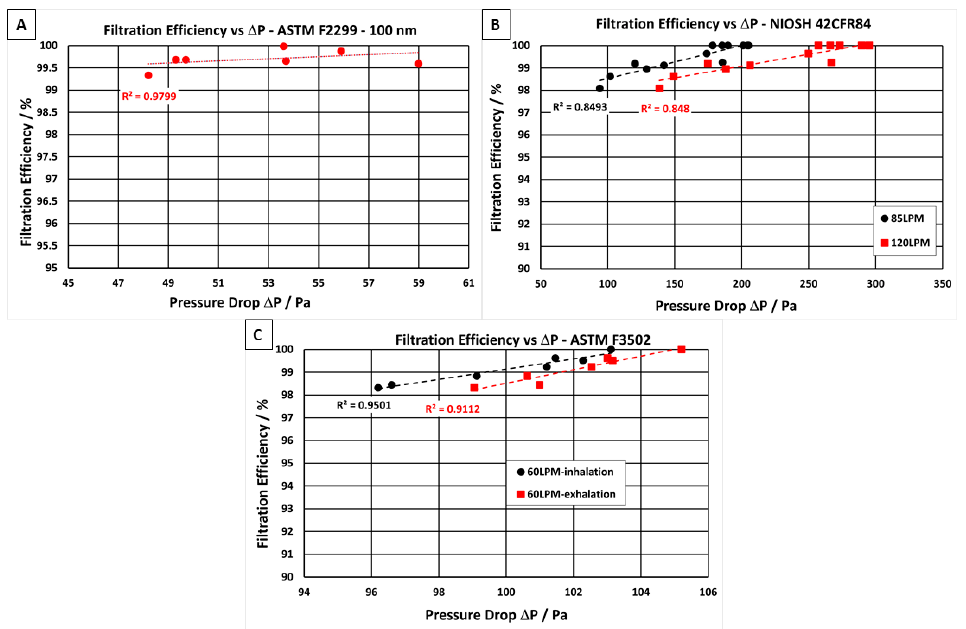
Figure 2. Filtration efficiency vs. pressure drop for PLA NF filter media tested in accordance with the following international standards: ( A ) ASTM F2299 [40], ( B ) NIOSH 42CFR84 [42] and ( C ) ASTM F3502 [41]. Table 4. Pressure drop and filtration efficiency results for PLA NF filter media tested in